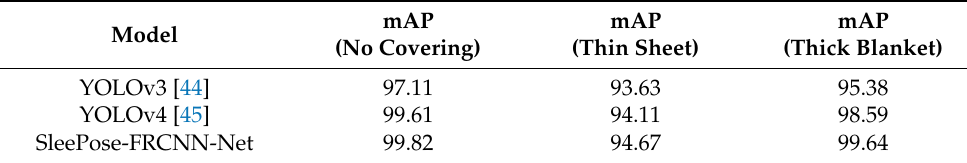
Table 10. Results of detection on the iSP pilot dataset.